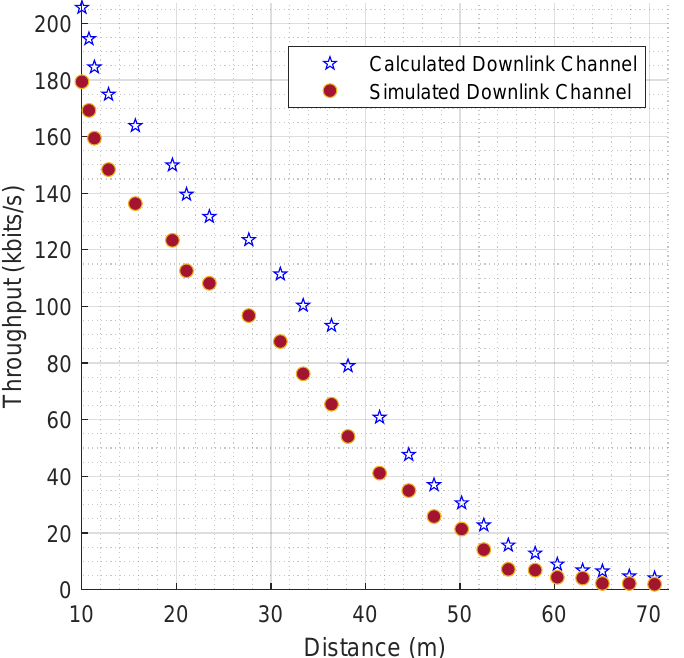
Figure 10. The evaluation of throughput (kbits/s) for both simulated and calculated NB-IoT downlink channels based on distances from the